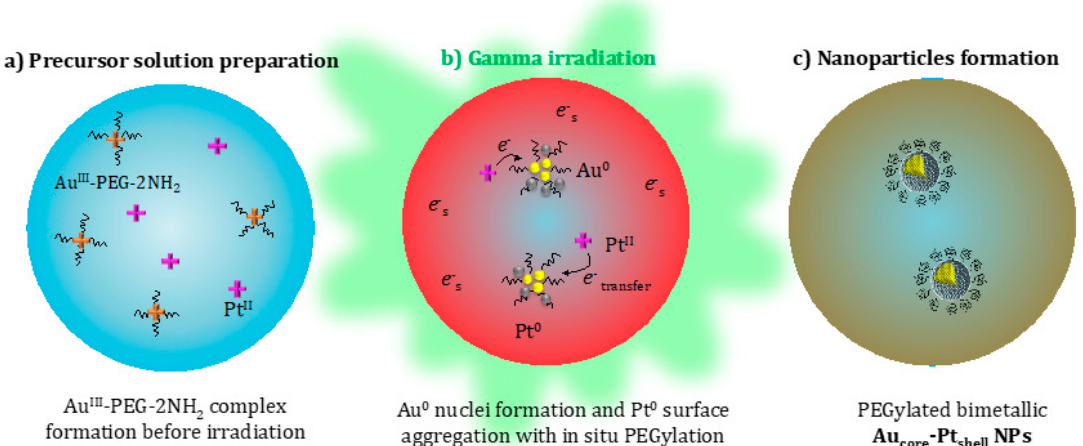
Figure 4. Schematic synthesis of Au:PtPEG-2NH 2 NPs by the formation of an Au III -PEG-2NH 2 complex ( a ), the radiolytic reduction of metal ions and early electron transfer from Pt to Au ( b ), and formation of Au core – Pt shell structured nanoparticles stabilized by PEG-2NH 2 ( c ).